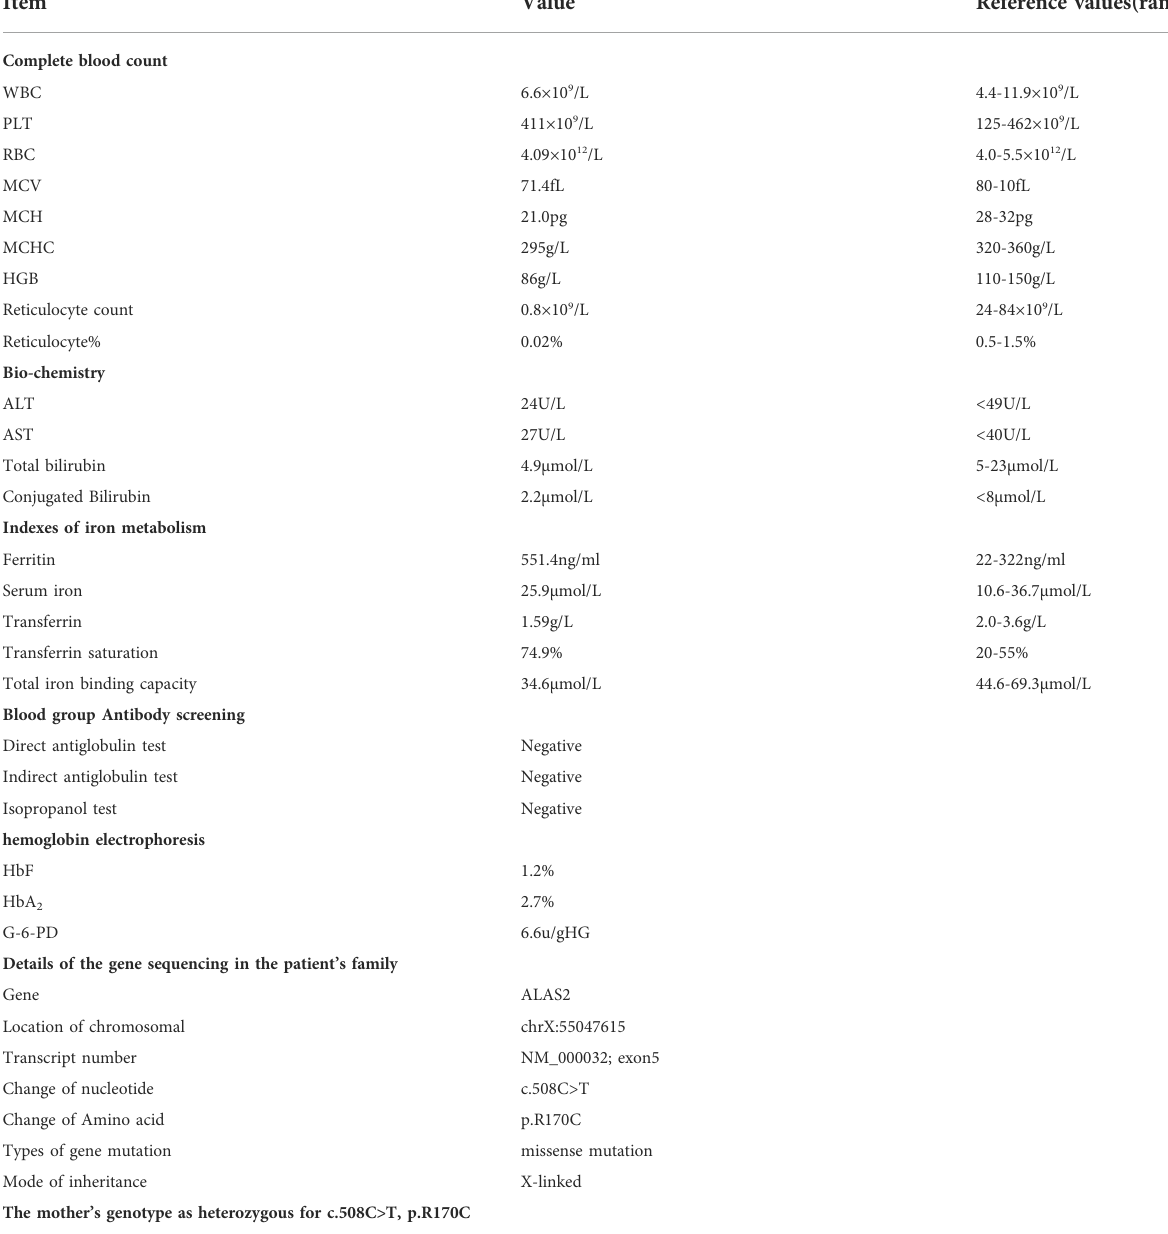
TABLE 1 Details of the laboratory examination before hematopoietic stem cell transplantation and results of gene